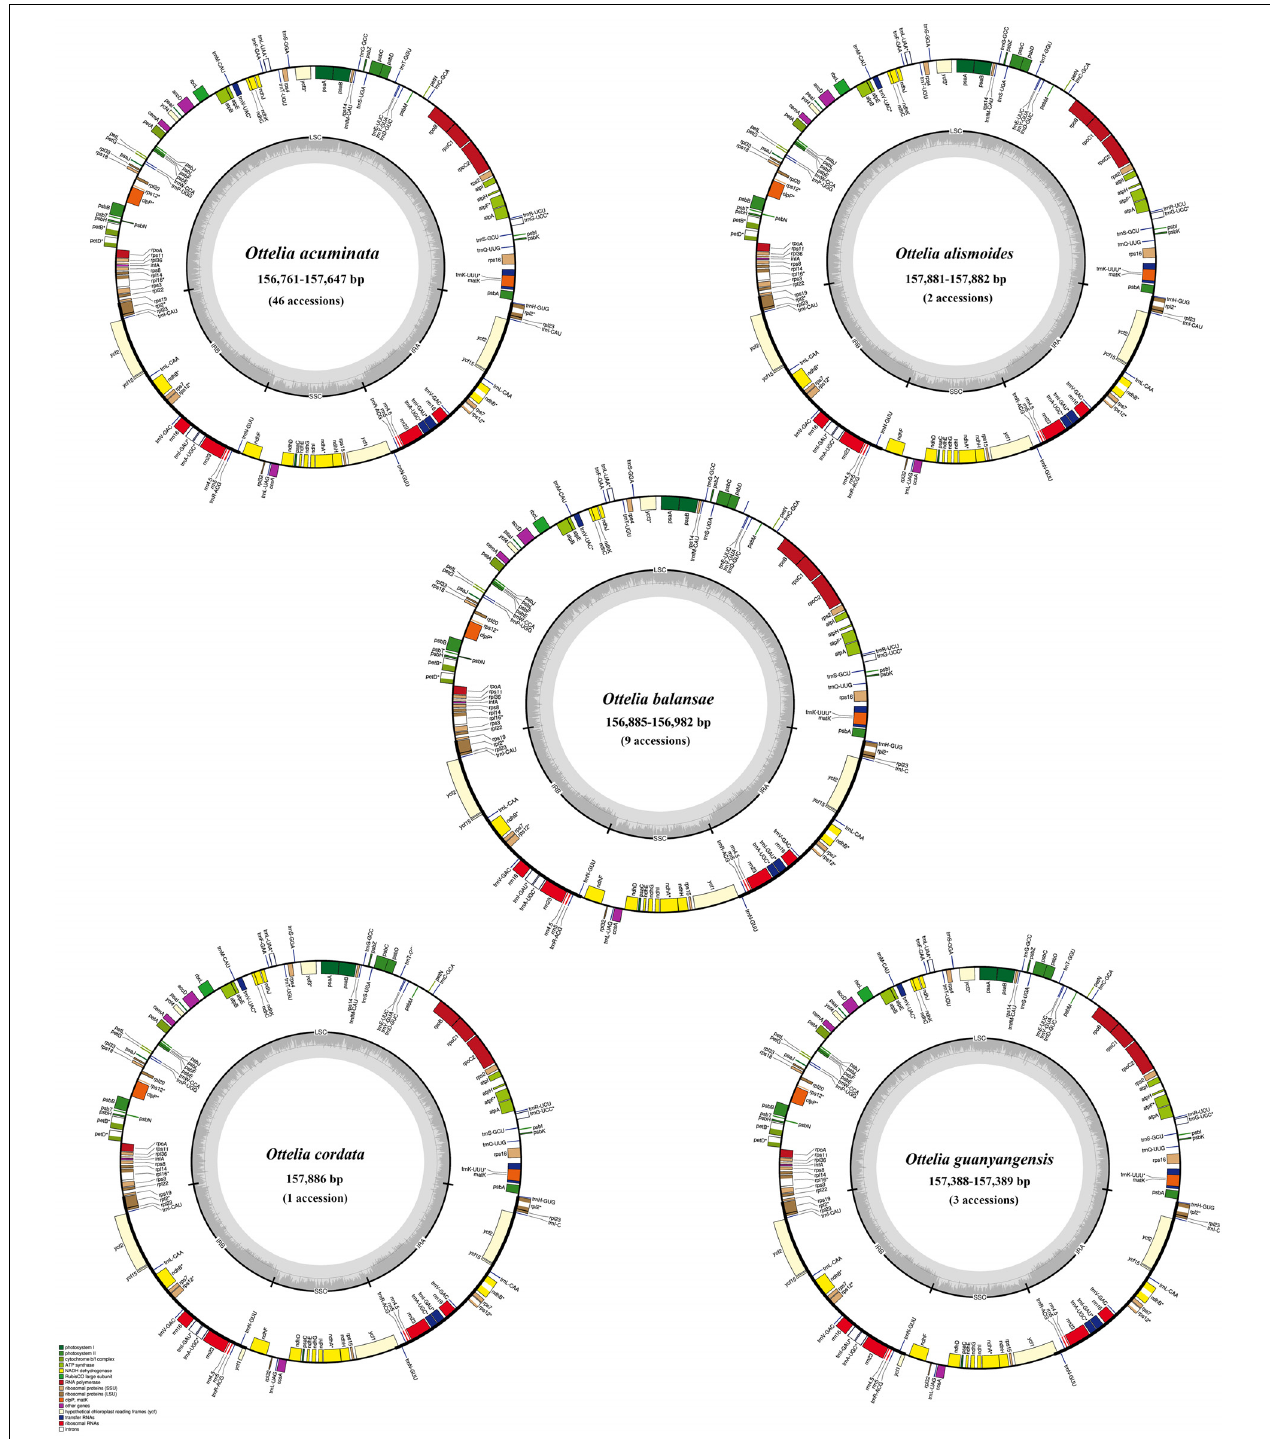
FIGURE 2 | Map of Ottelia plastomes. Genes shown outside the circle are transcribed clockwise, and those inside are transcribed counterclockwise.